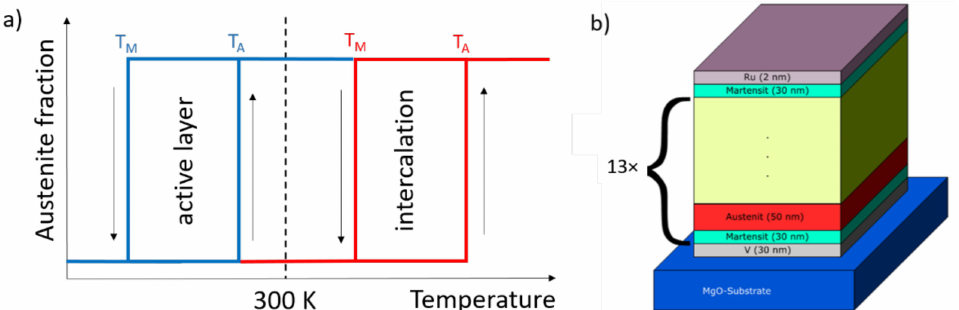
Figure 1. ( a ) The chosen compositions result in completely separated thermal hystereses for the active (blue) and intercalation layers (red). ( b ) Illustration of the sample system with 13 martensitic intercalations.